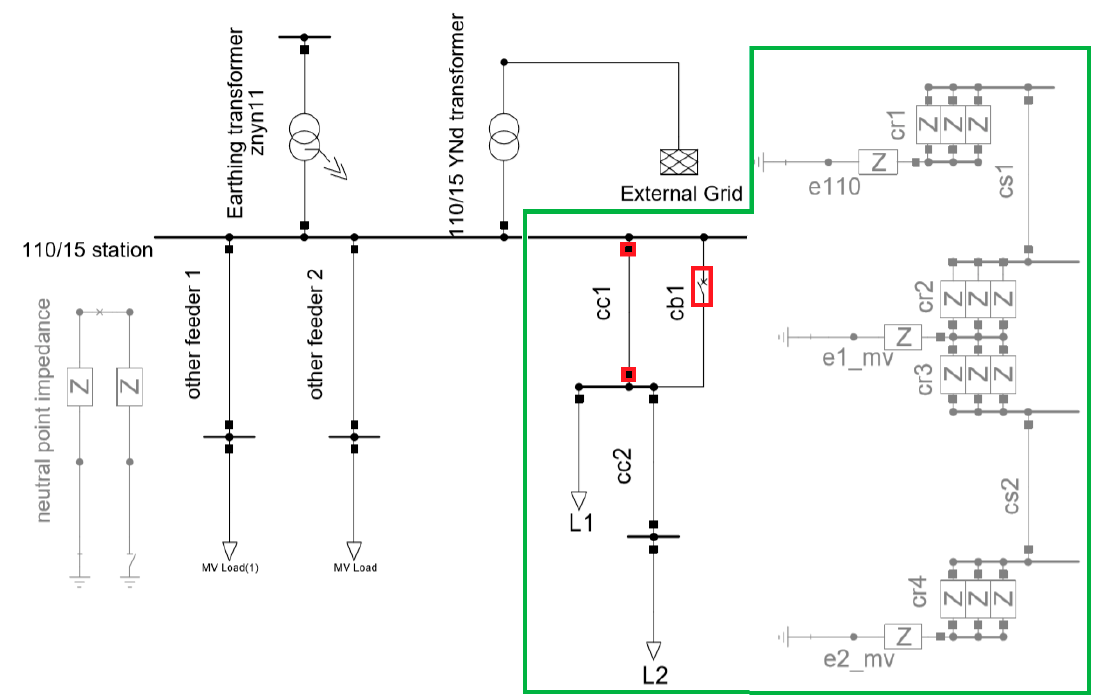
Figure 2. Power system model; cc—cable core, cs—cable screen, e110—substation earthing system resistance, and e1,2_mv—resulting resistance of MV transformer station.